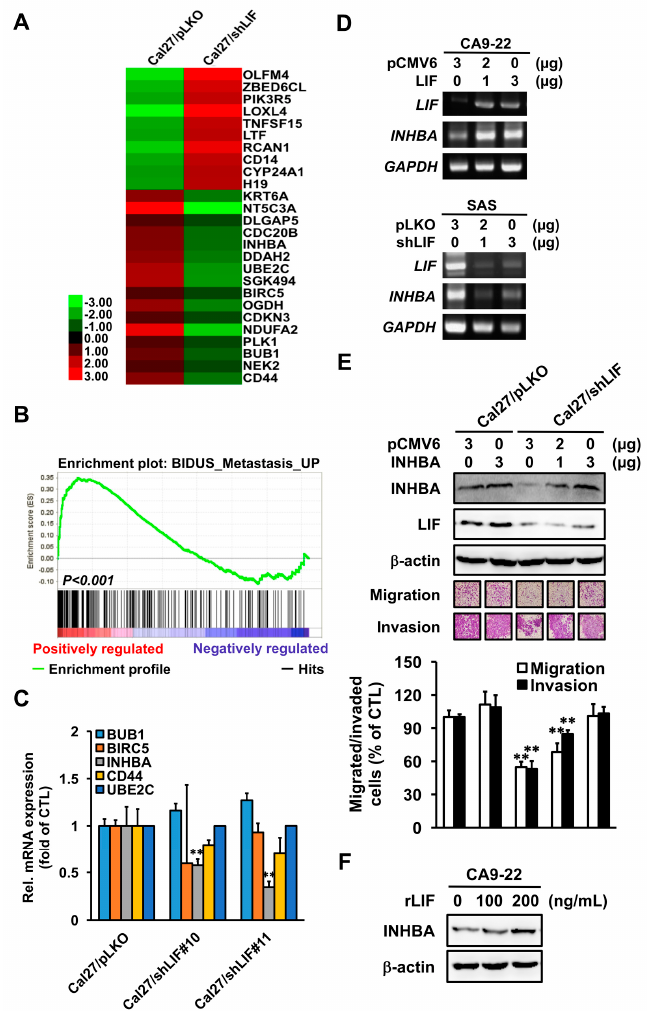
Figure 4. Inhibin beta A subunit (INHBA) as the major downstream e ff ector in LIF increases oral cancer progression. ( A ) Heatmap of mRNA expression profile in Cal27 / pLKO and Cal27 / shLIF stable clones. ( B ) Gene set enrichment analysis (GSEA) showed the enrichment of metastatic genes in Cal27 / pLKO versus Cal27 / shLIF cells. ( C ) Real-time PCR analysis of BUB1 , BIRC5 , INHBA , CD44 , and UBE2C mRNA expression in Cal27 / pLKO and Cal27 / shLIF cells (** p < 0.01). ( D ) Reverse transcription PCR analysis of INHBA mRNA expression in CA9-22 and HSC3 cells transiently transfected LIF-expressed or shLIF plasmids. ( E ) Cal27 / pLKO and Cal27 / shLIF stable clones were seeded and transiently transfected with 3 µ g of control plasmid or various concentrations of INHBA plasmids and incubated for 48 h,